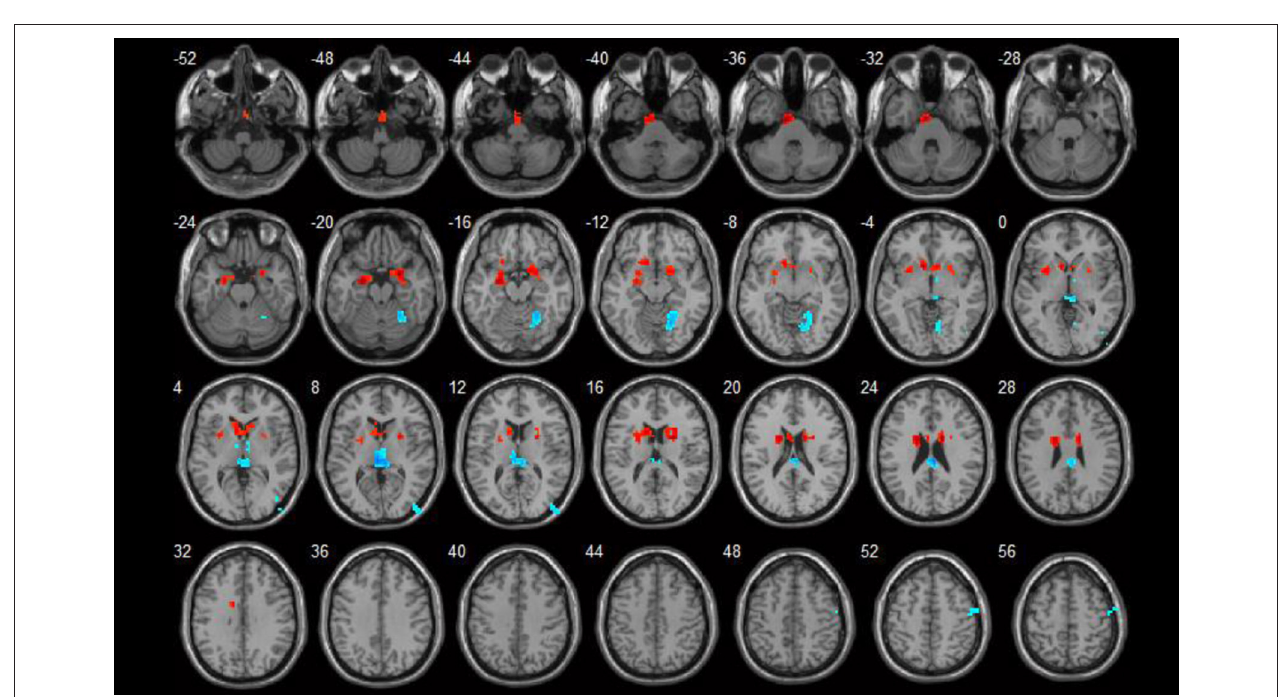
FIGURE 1 | ReHo value differences between SLE and HC groups ( p < 0.05). Red spots show areas with increased ReHo values in SLE patients, while blue ones show those with decreased ReHo